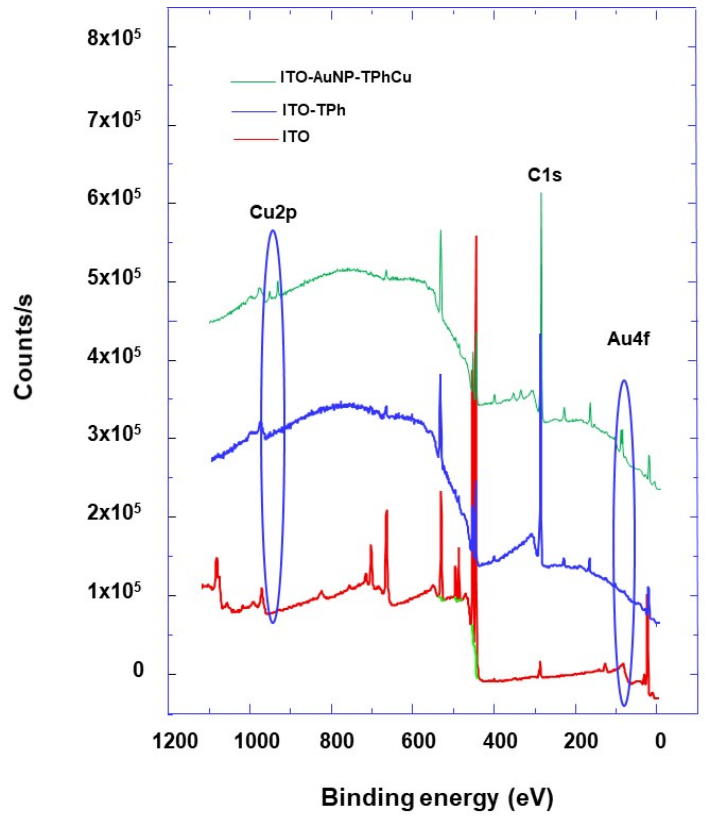
Figure 5. X-ray photoelectron spectroscopy (XPS) survey spectra of the various designs of electrodes modified with AuNPs and 4-thiolphenyl as indicated.